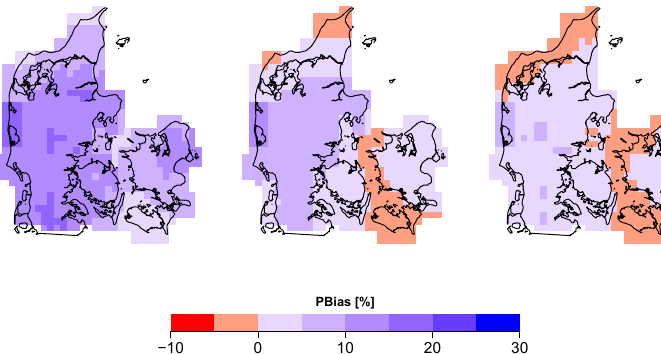
areas where biases are lower tend to have the highest ben- efits over ensemble climatology, i.e., precipitation in March across Denmark or in November in western Jutland. Skill related to accuracy was also mapped for lead times